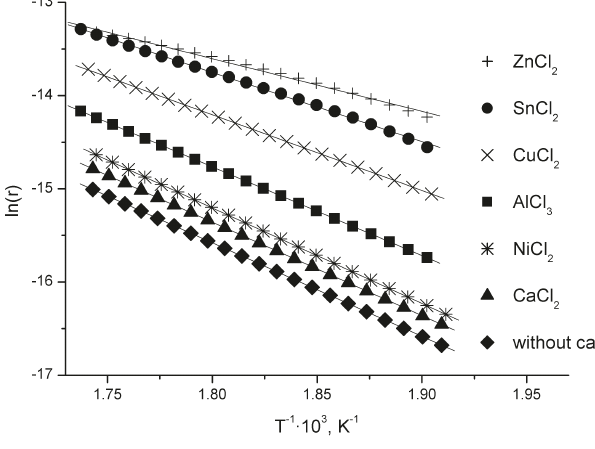
and ZnCl and without catalysts at heating rate 10°C min -1 . 2 2